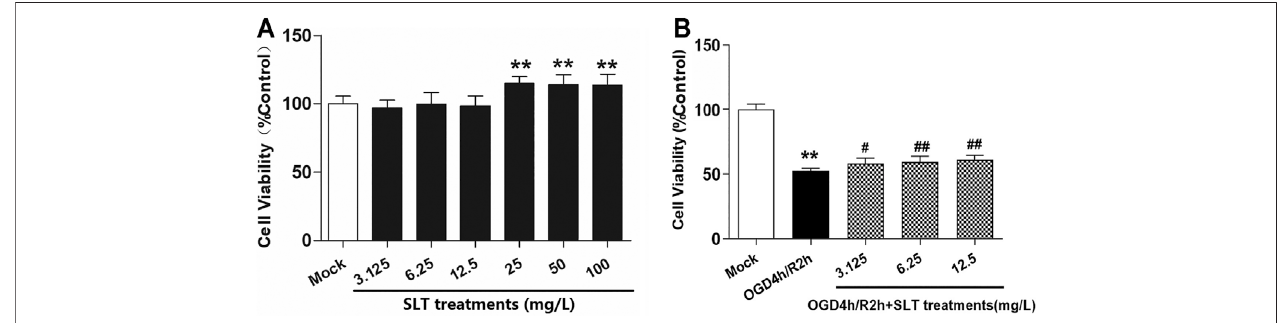
FIGURE4| SLTalleviatedOGD/RinjuryinhCMEC/D3cells. (A) ToxicitytestofSLTonhCMEC/D3cells( n (cid:1) 6).Thecellswereculturedwithdifferentconcentrations of SLT (3.125, 6.25, 12.5, 25, 50, and 100 mg/L) for 24 h, and the cell viabilities were examined by the CCK-8 method. (B) The therapeutic effects of SLT on OGD/R injury in hCMEC/D3 cells ( n (cid:1) 6). Data are expressed as mean ± SD. * p < 0.05, ** p < 0.01, vs. the mock group; # p < 0.05, ## p < 0.01, vs. the OGD/R